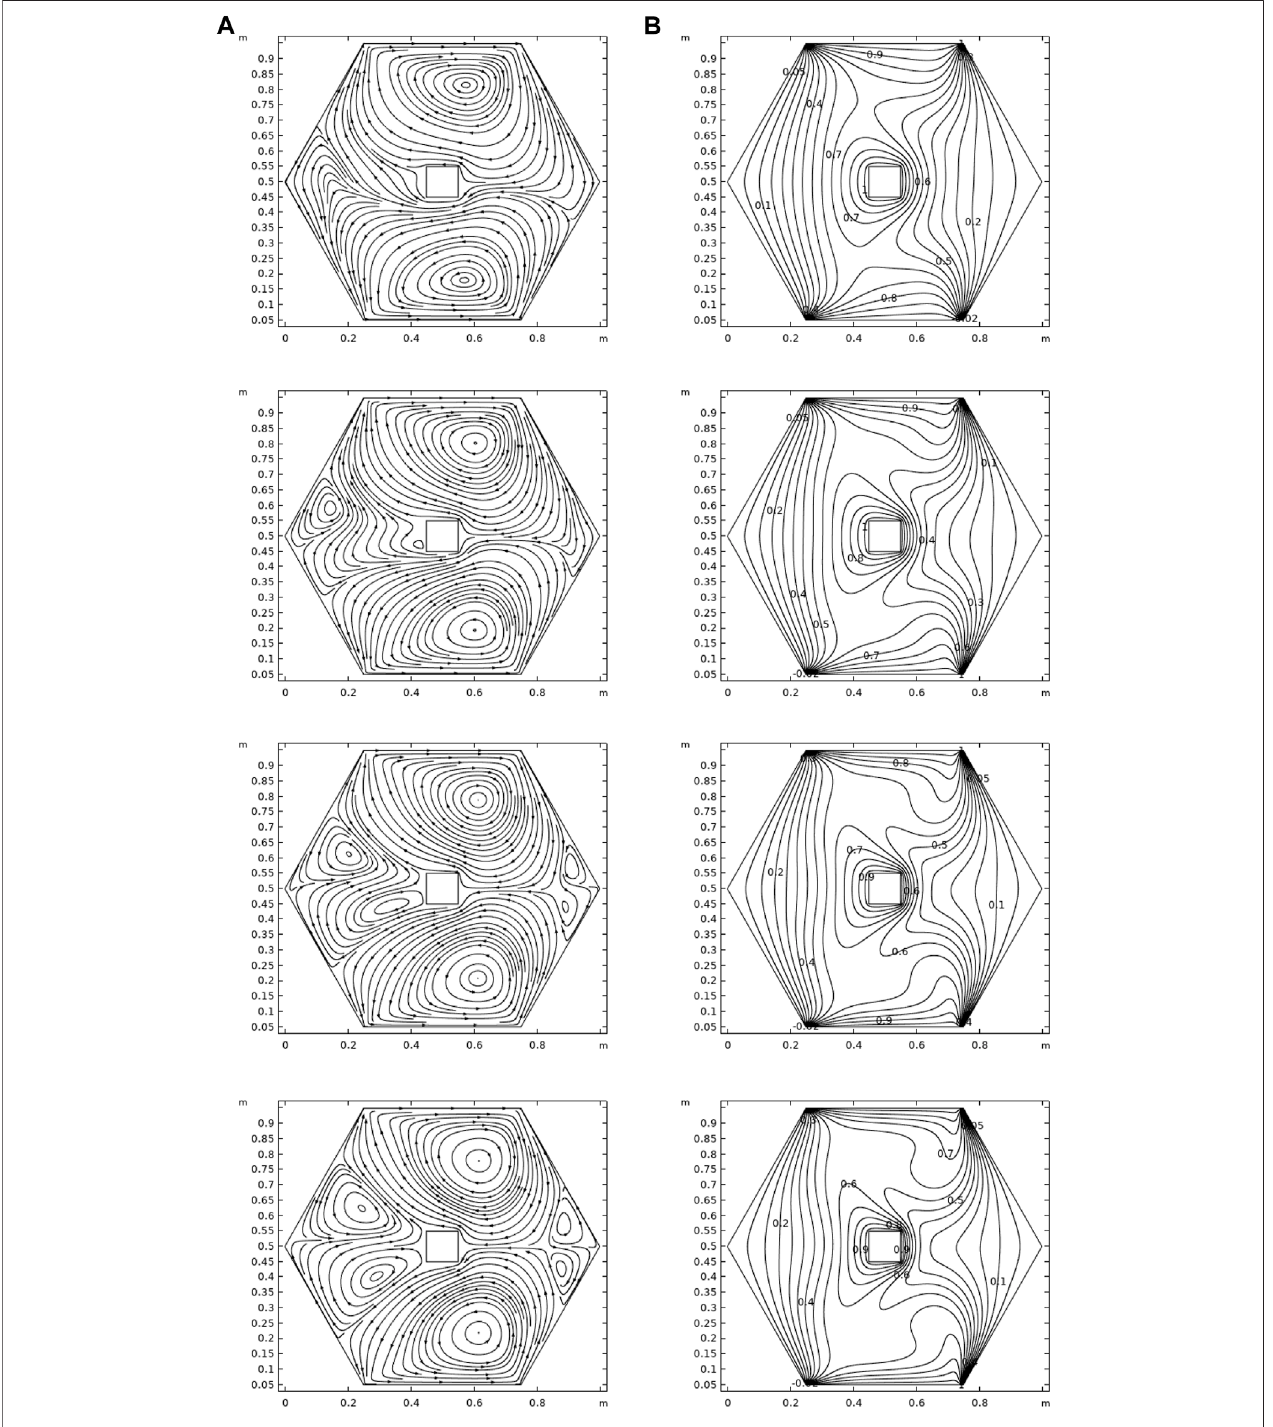
FIGURE 3 | In fl uence on streamline (A) and isotherm (B) with different Re with n (cid:2) 0 . 5 , Gr (cid:2) 1000, and Pr (cid:2) 1 .